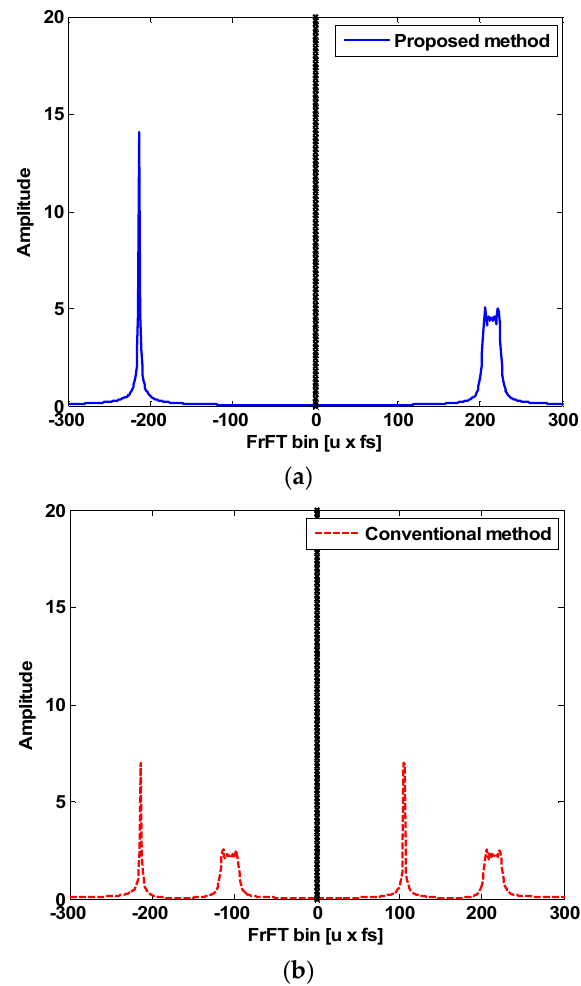
Figure 6. FrFT spectrum comparison between ( a ) the proposed method, and ( b ) the conventional method.